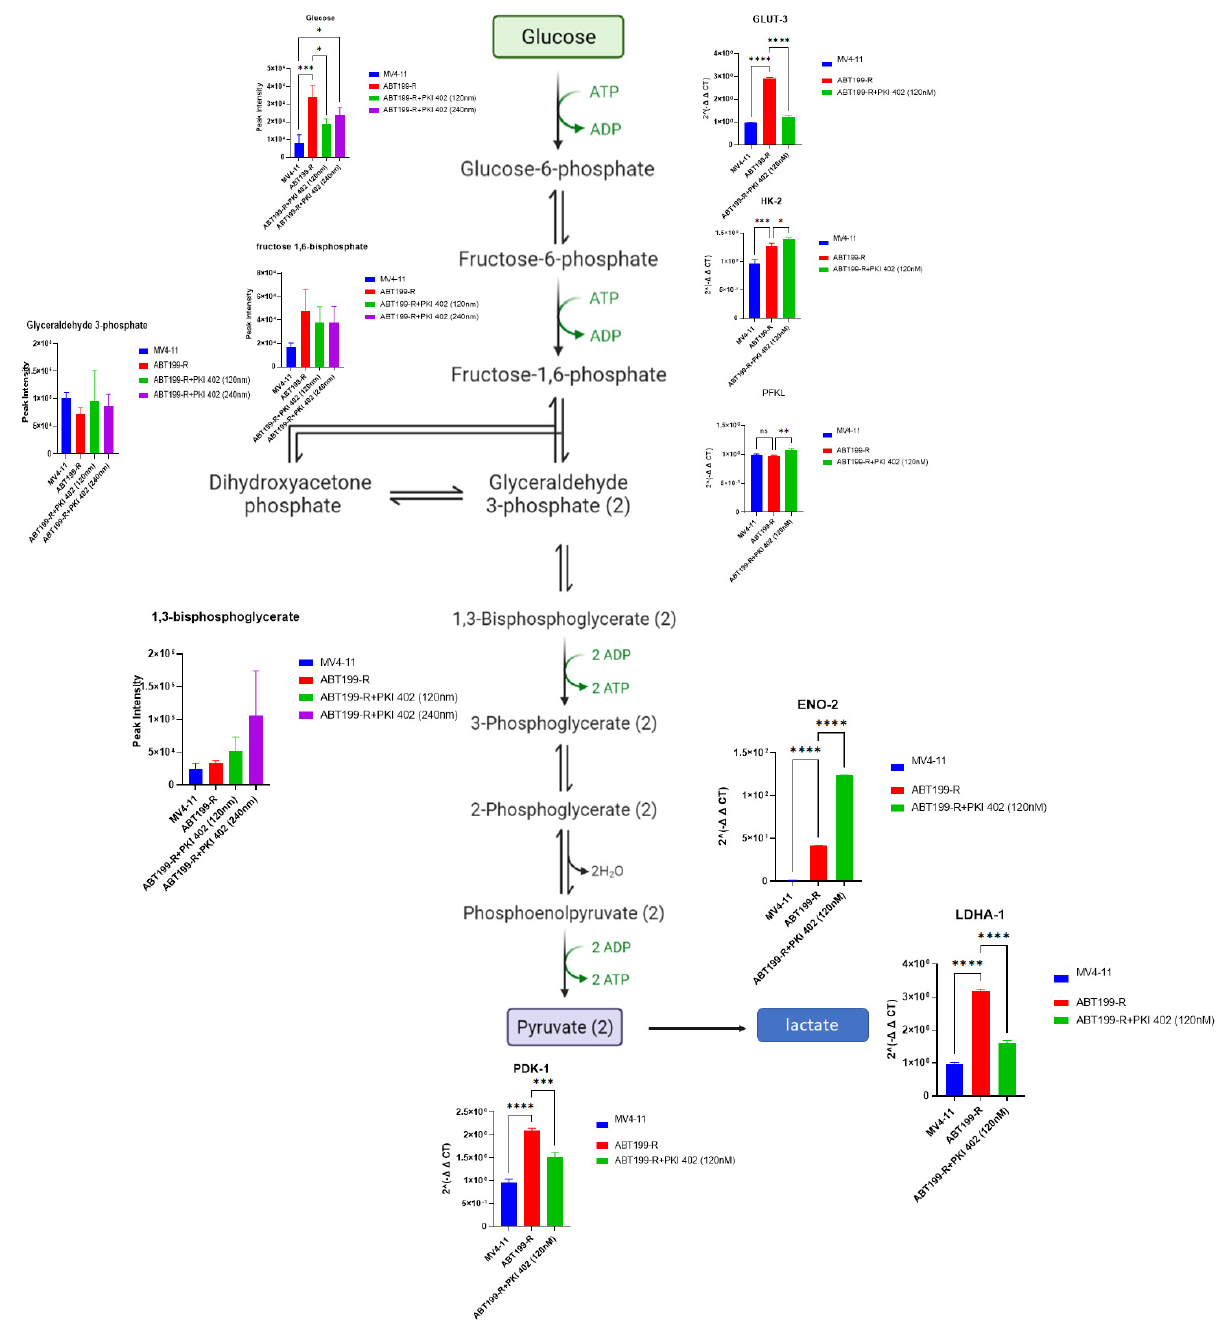
Figure 5. Venetoclax-resistant ABT199-R cells alter the glycolysis pathway. ( Left ) Quantitative levels of various metabolites involved in glycolysis pathways of MV4-11 cells, ABT199-R cells, and ABT199-R cells treated with PKI-402. ( Right ) Gene expression (RT-PCR) of various genes involved in glycolysis. * p < 0.05, ** p < 0.01, *** p < 0.001, and **** p < 0.0001.